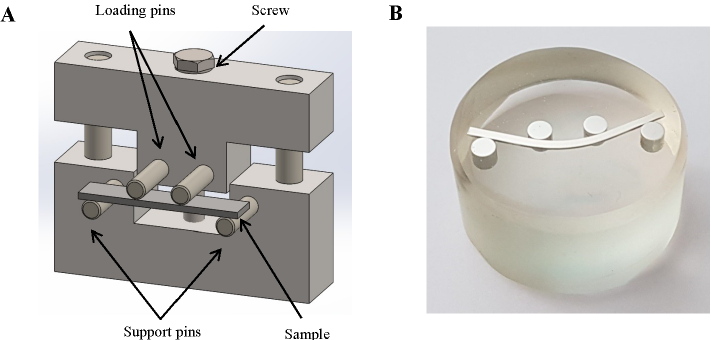
Figure 1. ( A ) Four-point bending device. ( B ) Bended sample embedded in epoxy for material